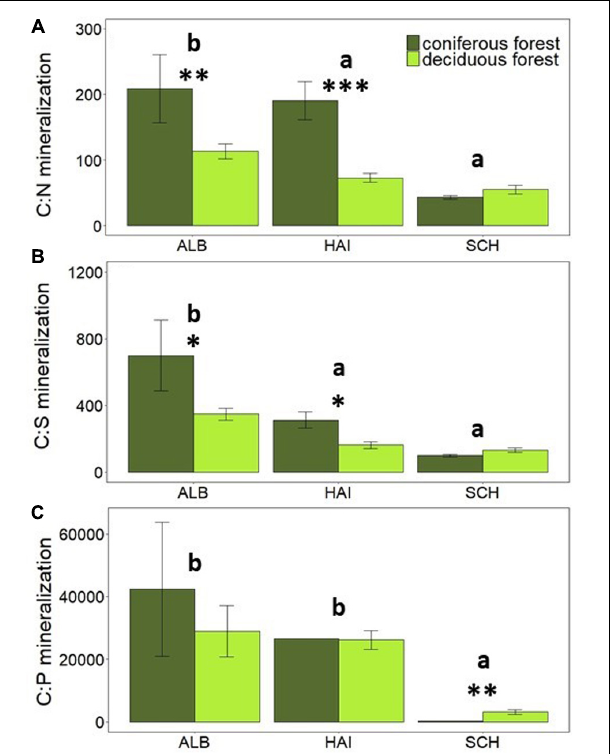
FIGURE 5 | Comparison of average mineralization rates of C-to-nutrients: (A) C:N mineralization, (B) C:S mineralization and (C) C:P mineralization in different forest types. Error bars represent SE of means. X -axis represents study regions where ALB, Schwäbische-Alb; HAI, Hainich-Dün; SCH, Schorfheide-Chorin. Significant differences of variance between study regions are denoted by small letters, and between coniferous and deciduous forests are denoted by ∗ P < 0.05, ∗∗ P < 0.01, and ∗∗∗ P < 0.001. Number of study sites included: ALB (deciduous forests, n = 38 and coniferous forest, n = 12), HAI (deciduous forests, n = 46 and coniferous forest, n = 4), and SCH (deciduous forests, n = 28 and coniferous forest, n =